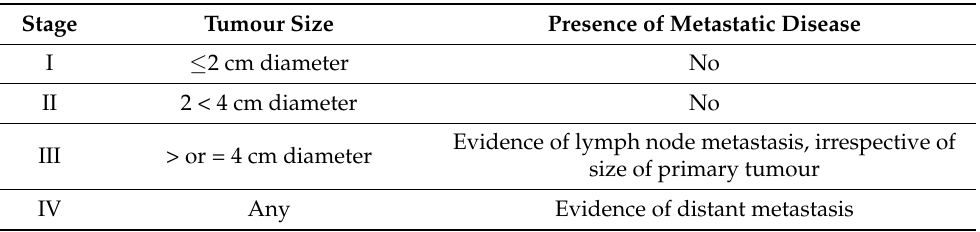
Table 1. WHO criteria for staging canine oral melanoma on the basis of size and/or presence of metastatic disease